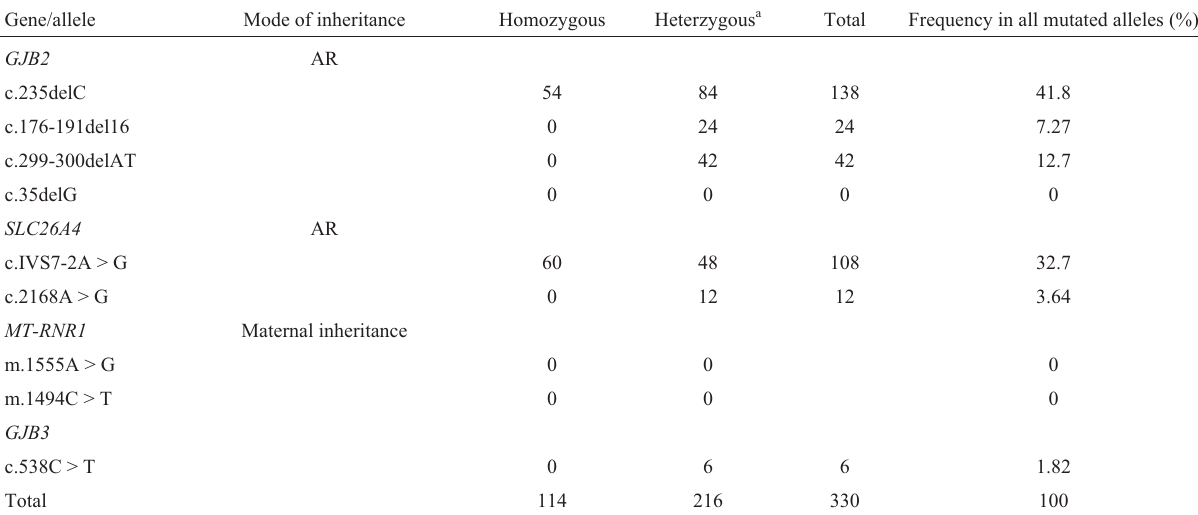
Table 2 - Frequencies of the nine common deafness-associated alleles.